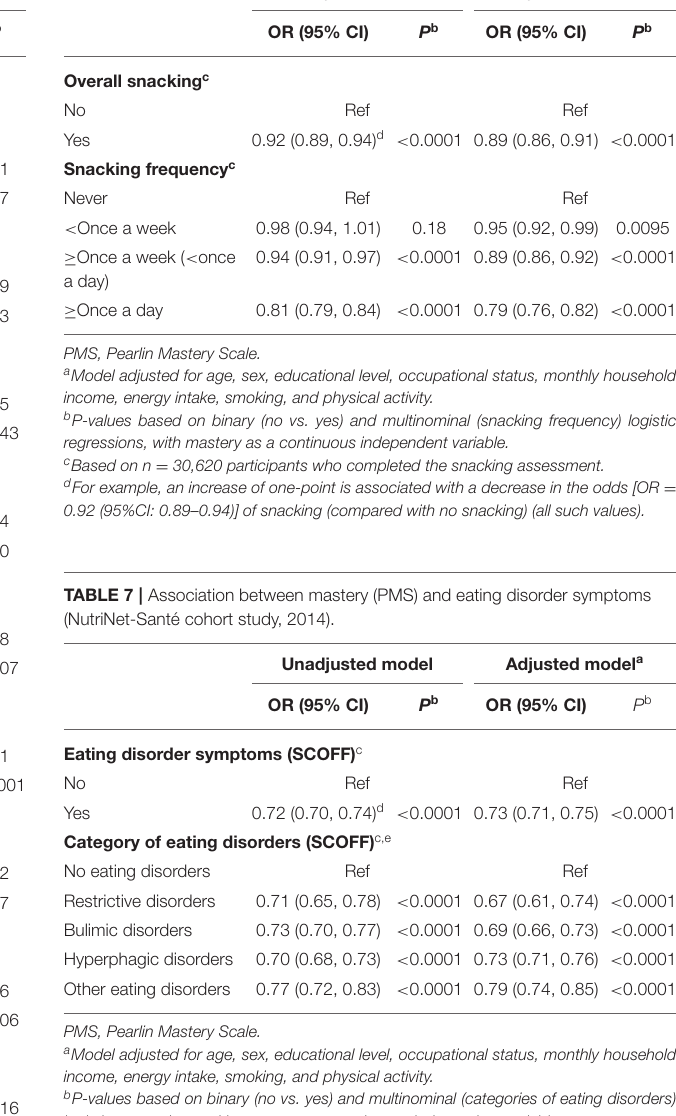
TABLE 6 | Association between mastery (PMS) and snacking (NutriNet-Santé cohort study, 2014). Unadjusted model